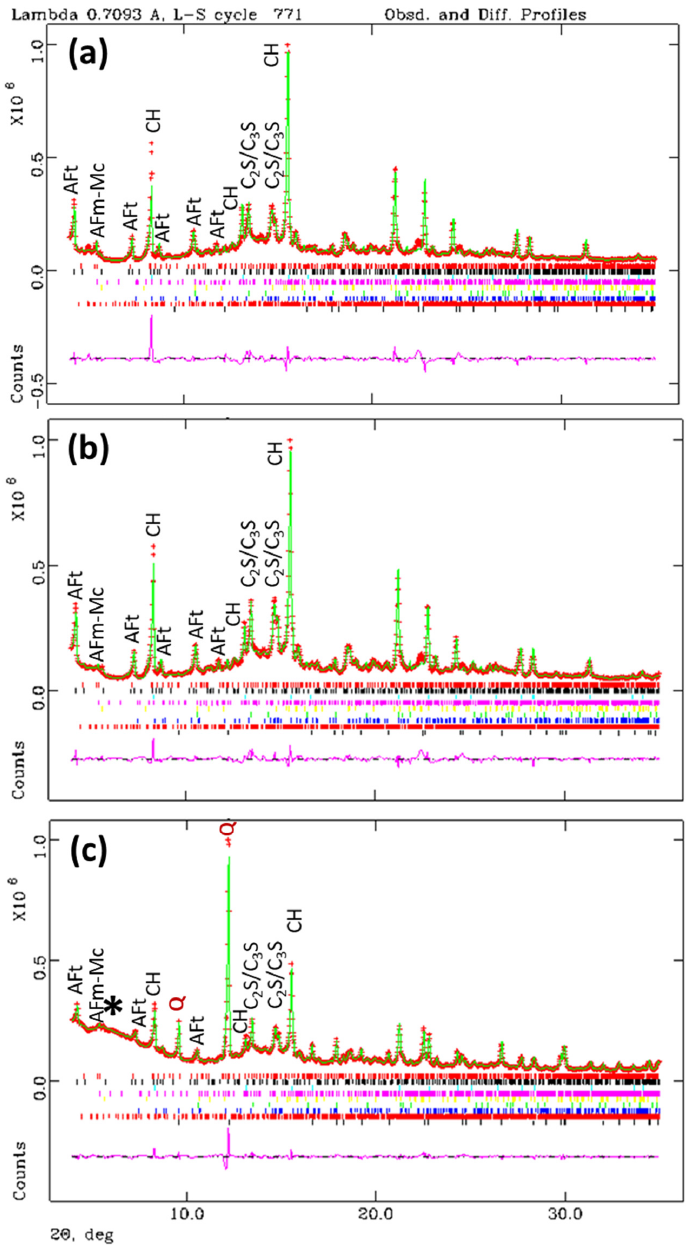
Figure 2. Rietveld plots, λ = 0.71 Å, for the w/c = 0.45 pastes hydrated at 20 °C for 50 days ( a ) sample within a capillary of φ = 0.5 mm, ( b ) sample within a capillary of φ = 1.0 mm, and ( c ) sample with the internal standard and between two Kapton foils. The hump due to the polymer (Kapton) is highlighted with a star. The sets of bars with different colours, above the difference curve, correspond to the crystalline phases computed. The main peaks, at low diffracting angles, are labelled. Q stands for quartz (the added internal standard).